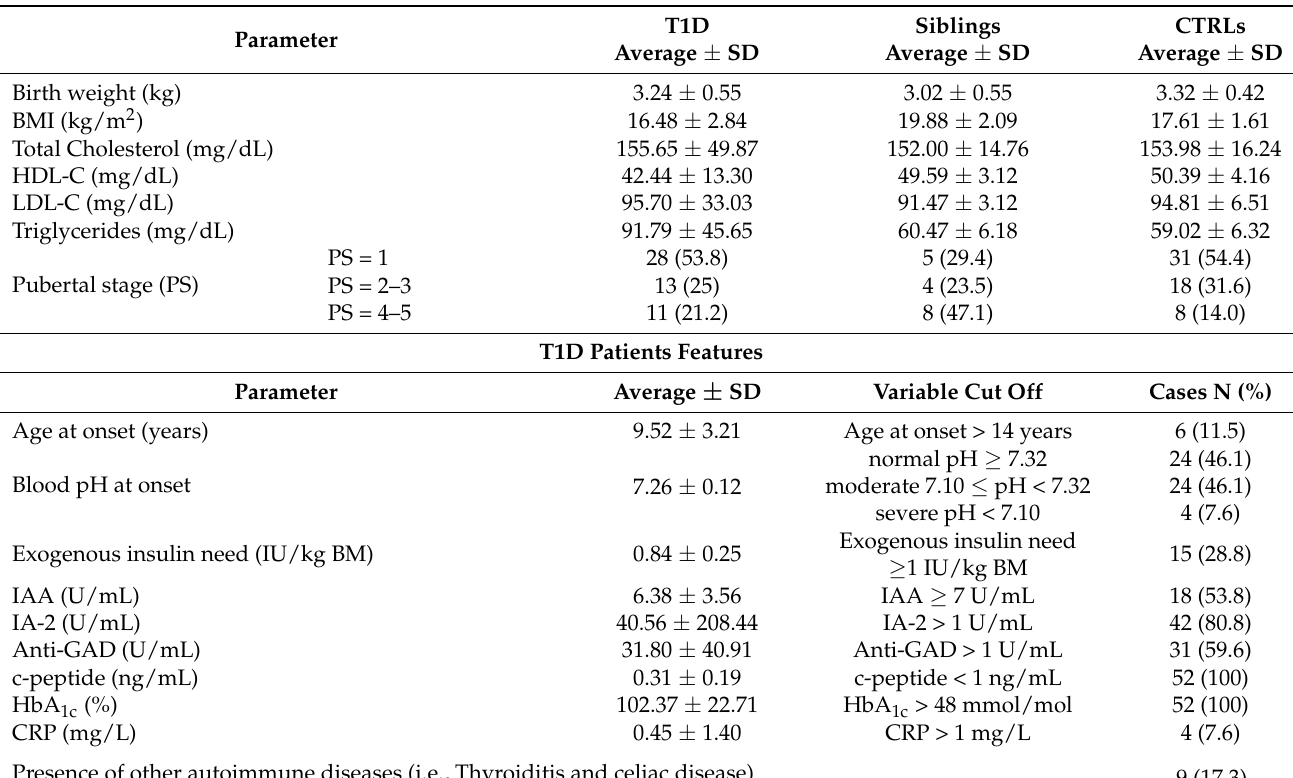
Table 1. Clinical and anthropometric parameters of T1D patients, siblings and